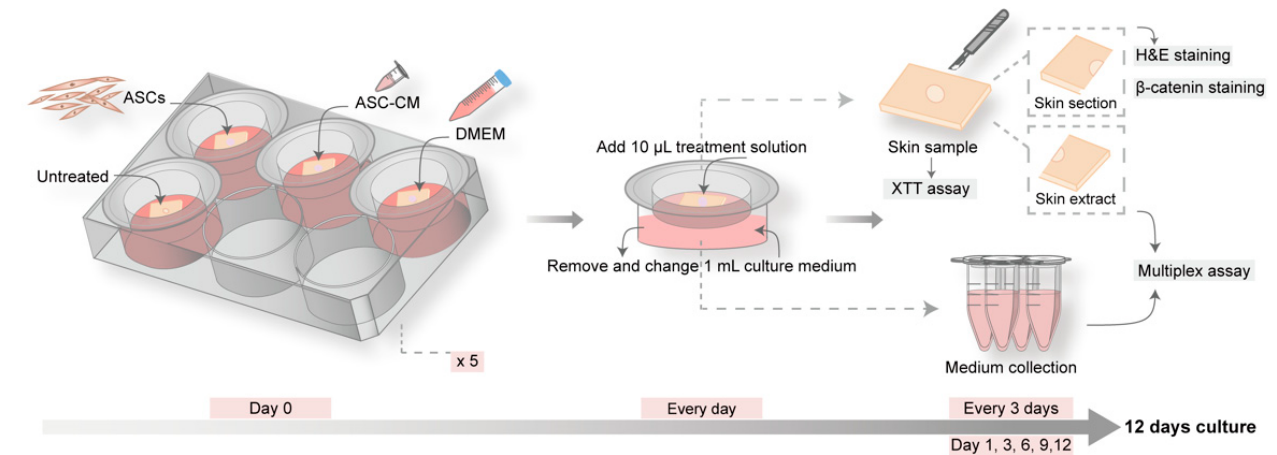
Figure 1. Schematic of the experimental protocol for the ex vivo wound model. Five culture plates were prepared with four skin pieces with one wound in the center. One group served as control and was left untreated, while the other three groups were topically treated with DMEM, conditioned medium of adipose-derived stem cells (ASC-CM), or adipose-derived stem cells (ASCs). Every day, 1 mL of medium was replaced and 10 µ L of conditioned medium or DMEM were added to the ASC-CM group or the DMEM and ASCs groups, respectively. At day 1, 3, 6, 9, and 12, one piece of skin sample and 1 mL of culture medium per group were collected. The skin pieces were used for the measurement of skin reductive activity (XTT test). Subsequently, the samples were cut into halves. One half was used for skin sectioning and histology, hematoxylin and eosin (H and E), and β -catenin staining. The other half was processed for protein extraction. Extracts and collected culture medium were used for multiplex analysis of growth factors and cytokines.